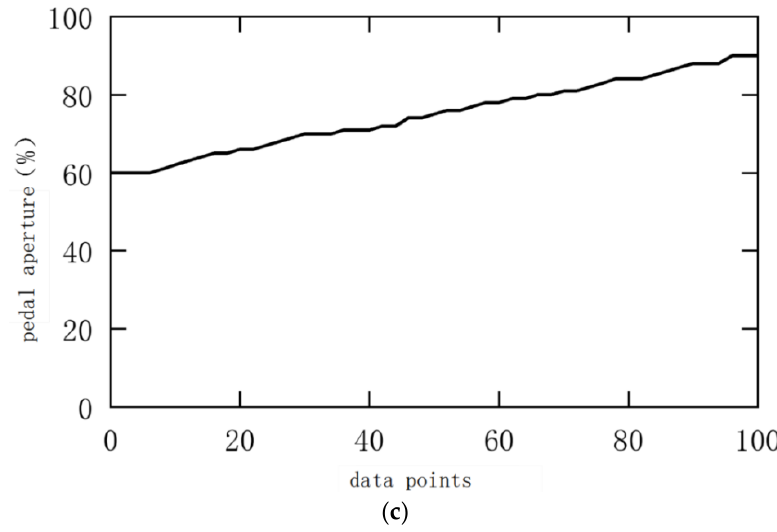
Figure 24. Pedal aperture signal changes under different acceleration conditions. ( a ) Accelerator pedal aperture 0–30%. ( b ) Accelerator pedal aperture 30–60%. ( c ) Accelerator pedal aperture 60–90%.